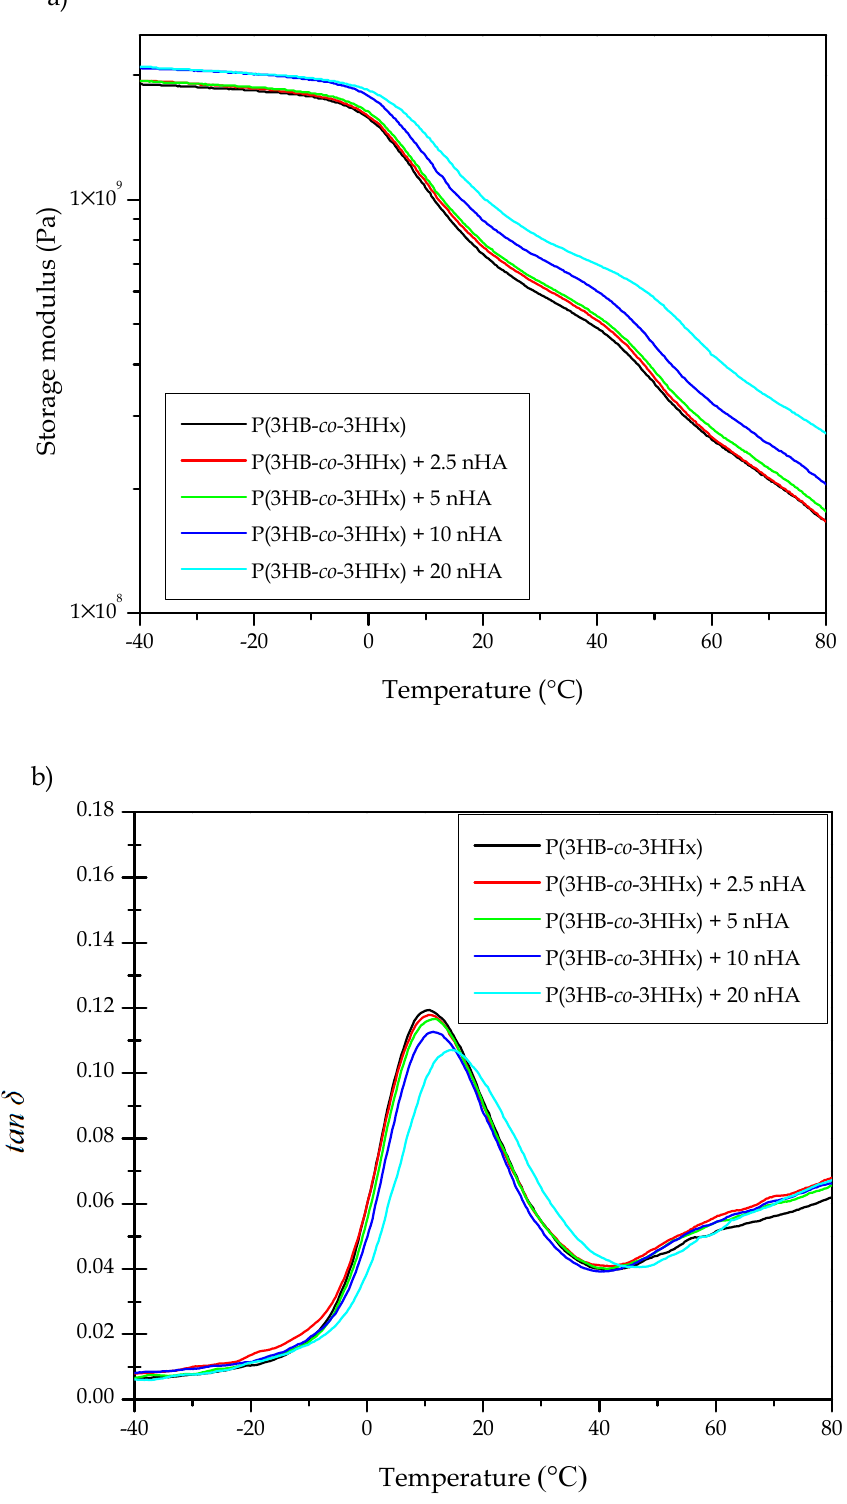
Figure 5. Evolution as a function of temperature of the ( a ) storage modulus and ( b ) dynamic damping factor ( tan δ ) of the injection-molded hydroxybutyrate- co -3-hydroxyhexanoate) [P(3HB- co -3HHx)] / hydroxyapatite nanoparticles (nHA) parts.